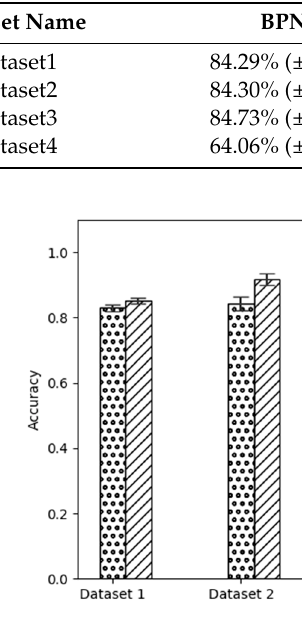
Figure 11. Comparison between BPNN and SVR fault detection accuracies.